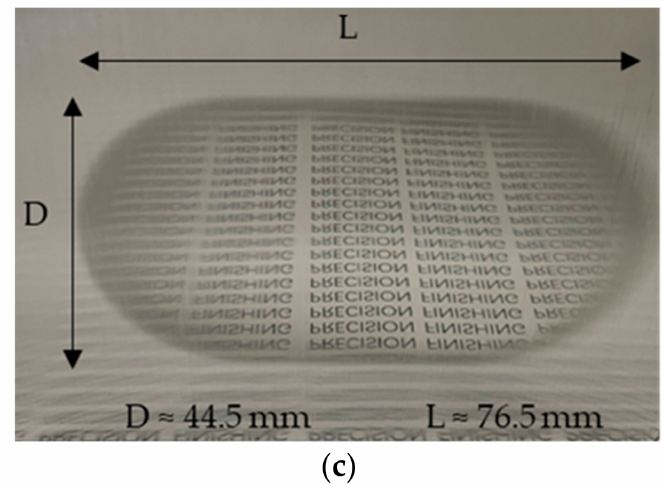
Figure 10. Photos of the workpieces. ( a ) Magnetic particles: 75 µ m; ( b ) Magnetic particles: 149 µ m; ( c ) Magnetic particles: 330 µ m.